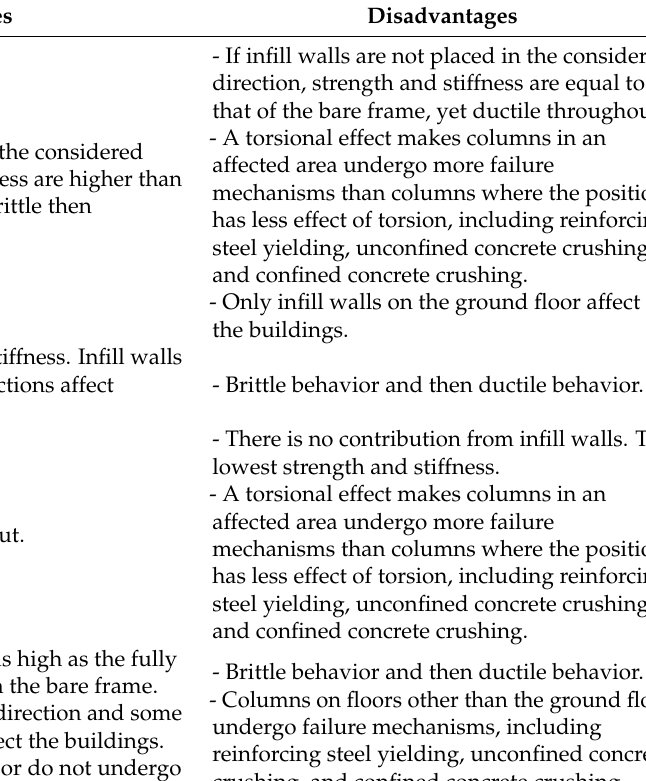
Table 5. The advantages and disadvantages of different infill wall